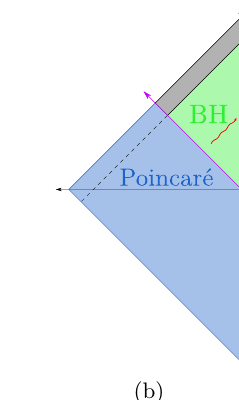
Figure 4 . (a) The setup in most of the literature. Due to the coupling at t = 0 a pulse is sent in forming the black hole. By setting transparent BC, evaporation is achieved and we have radiation in both directions. The dashed vertical line denotes the transparant BC. (b) Our setup of an evaporating black hole. A classical pulse is sent in and outgoing radiation is absorbed by the boundary observer. Nothing is ever reflected back